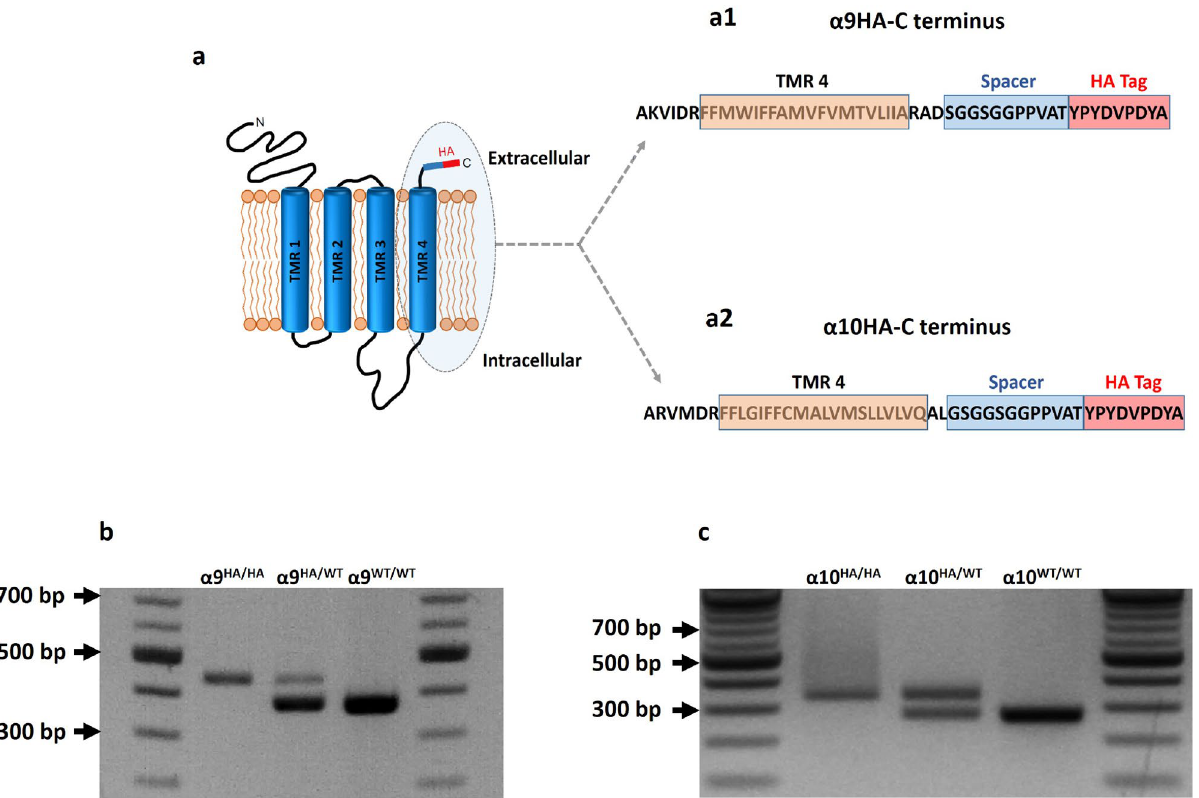
Figure 1. Schematic of α9 and α10 nAChR topology in membrane bilayer ( a ) with an enhancement of the shaded ellipse of the C-terminus of α9 ( a1 ) and α10 ( a2 ). Amino acid sequence depicting part of the intracellular loop, the transmembrane region 4 (TMR 4) and the extracellular amino acids attached to the HA tag complex (Spacer blue box + HA red box). The gel images show predicted PCR products for WT mice and HA tagged α9 ( b ) and α10 ( c ) HA/HA and HA/WT mice. The predicted sizes are 435 bp α9 HA/HA , 375 bp WT/WT, 334 bp α10 HA/HA and 271 bp for